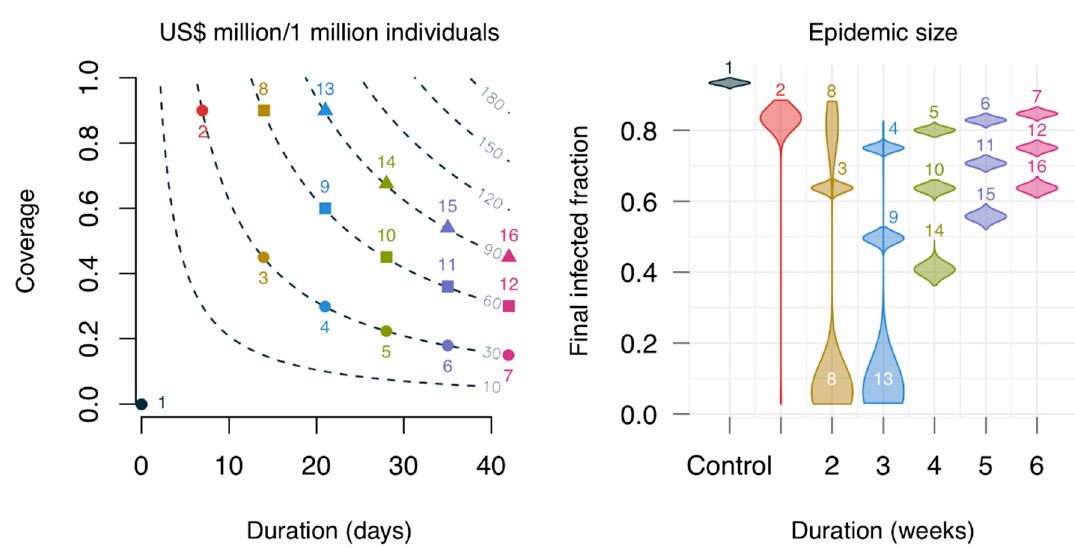
Figure 7. Effects of using oseltamivir on epidemic size with respect to different combinations of duration and coverage. The contour lines on the left panel show the cost in US dollars per individual, assuming the pandemic regimen (150 mg, twice daily) with 0.16 US cents per mg [22]; the numbers denote the simulated scenarios. The violin plots on the right show the epidemic size distribution for the simulated scenarios, each corresponding to 1000 simulations. Colors on both panels indicate the same simulated scenarios. The distribution in scenario 8 is bimodal, while those of scenarios 2 and 13 are skewed.